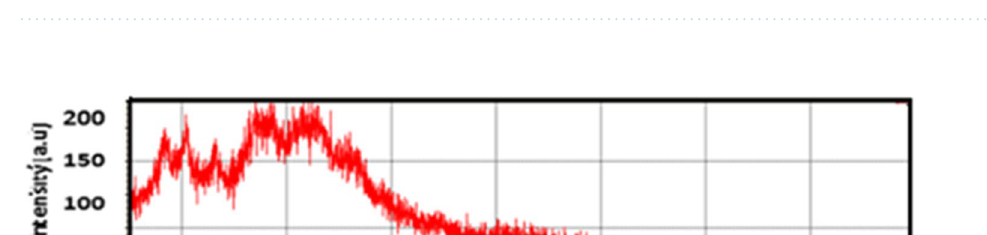
Figure 5. FTIR spectrum of Nanocellulose acetate compared with pristine cellulose acetate and Nanocellulose powder.